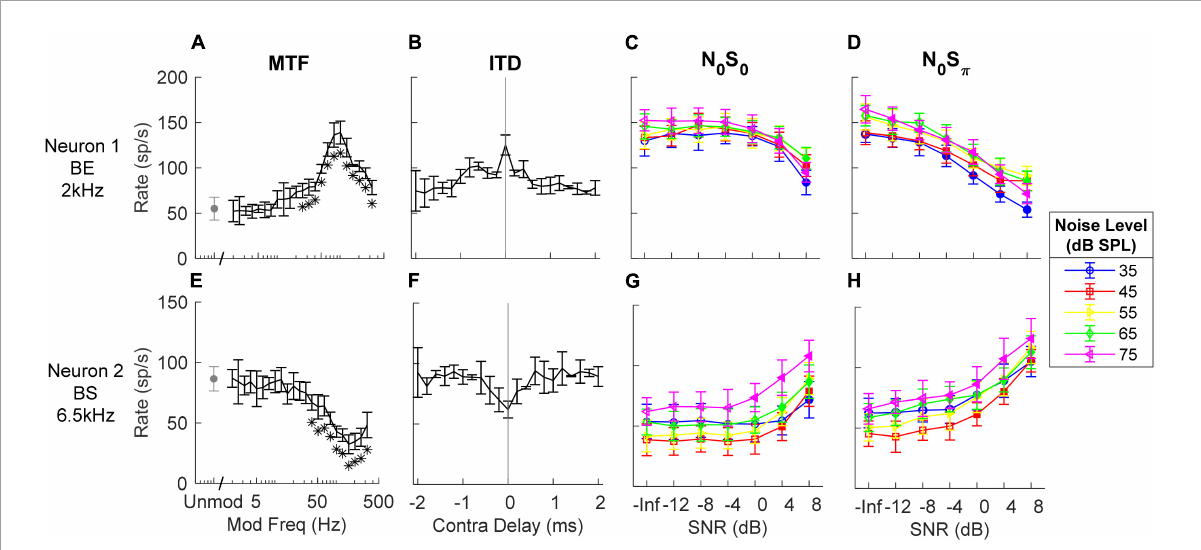
FIGURE3 Responses of two example neurons ( top and bottom row respectively). (A,E) MTF, response rates to amplitude-modulated noise; stars indicate modulation frequencies that had rates significantly different from the unmodulated condition. (B,F) ITD sensitivity, response rates vs. time delay in contralateral side (negative indicates ipsilateral side has delay). (C,D,G,H) Responses to N 0 S 0 and N 0 S π stimuli at different noise levels (different symbols) vs. SNR (from left to right); filled symbols indicate supra-thresholds. Errorbars indicate standard deviation. MTF shape and tone frequency for TIN stimuli (close to CF) are shown on the left. The example BE neuron had decreasing rate upon addition of a tone for both N 0 S 0 and N 0 S π , while the example BS neuron had increasing rate for both